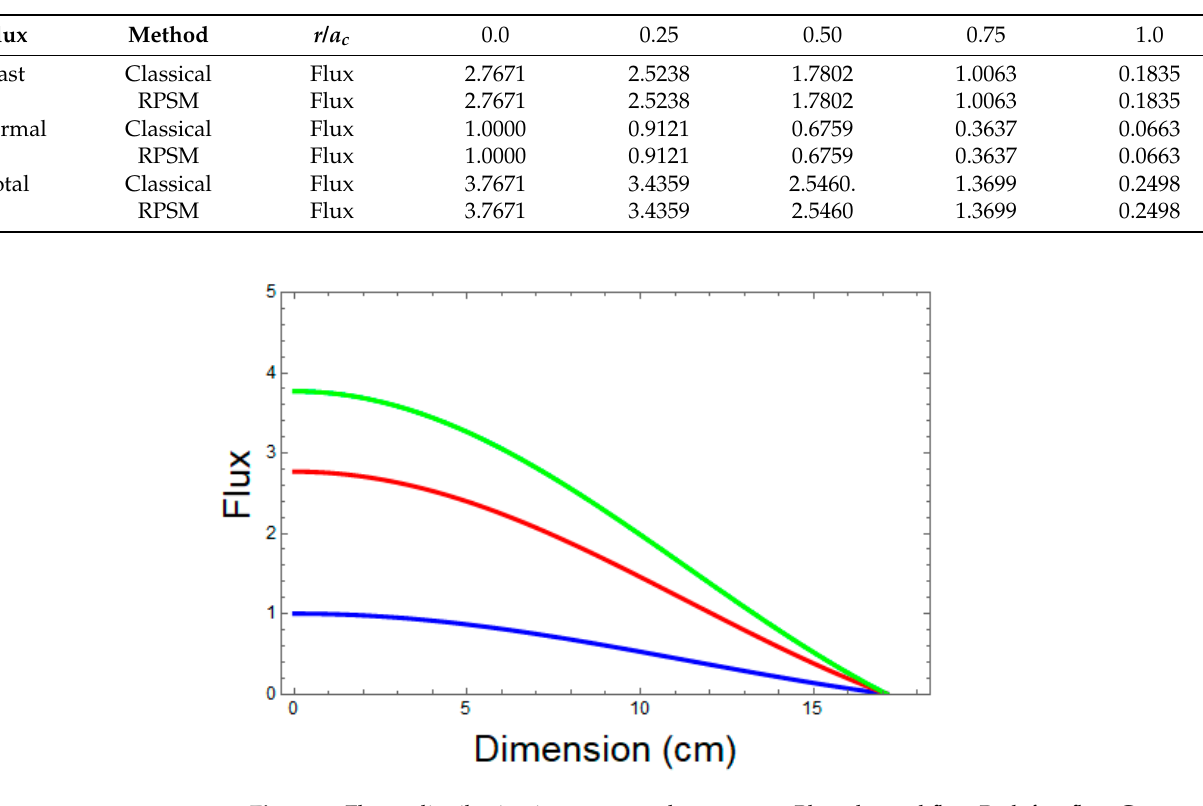
Figure 3. Fluxes distribution in two ‐ group bare reactor. Blue, thermal flux; Red, fast flux; Green, total flux.